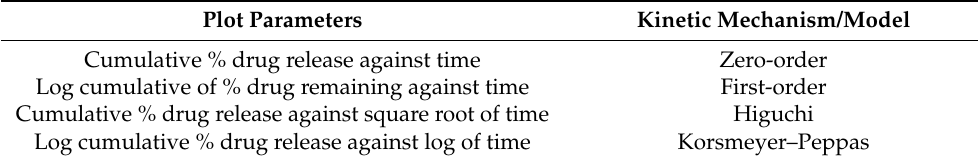
Table 5. Various equations describing relationship between drug release and time. Plot Parameters Kinetic Mechanism/Model Cumulative % drug release against time Zero-order